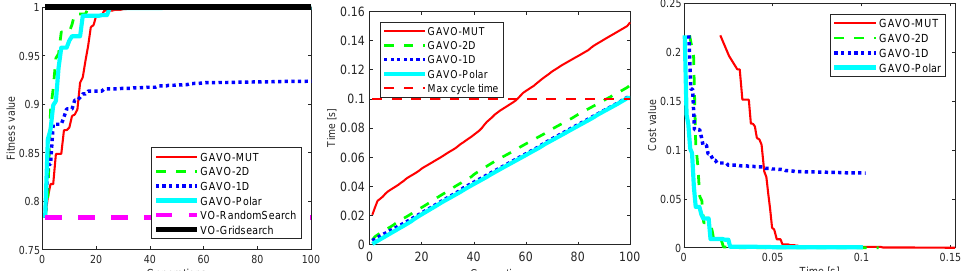
Figure 5. Results of experiments with the sparse scenario for the variations of GAVO with N = 20 and GAP = 10. VO-RandomSearch and VO-GridSearch serve as baselines that do not change with the generation. ( left ) Evolution of the fitness value with the generations, ( center ) time for a specific number of generations, ( right ) the trade-off between wall clock time and cost defined as